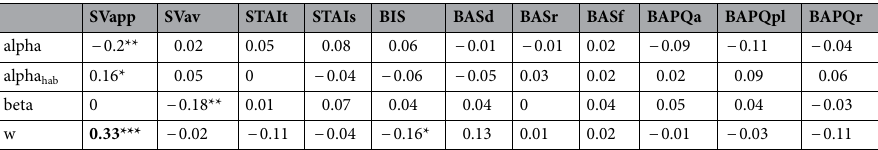
Table 3. Spearman’s correlations between counterfactual model parameters and subjective measures. Correlations in bold survive FDR correction for multiple comparisons.SVapp = subjective value for approach scenarios, SVav = subjective value for avoidance scenarios, BIS = Behavioral Inhibition System, BASd = Behavioral Activation System, Drive subscale, BASr = Behavioral Activation System, Sensitivity to Reward subscale, BASd = Behavioral Activation System, Funseeking subscale, BAPQa = Broad Autism Phenotype Questionnaire, Aloof Personality, BAPQpl = Broad Autism Phenotype Questionnaire, Pragmatic Language, BAPQr = Broad Autism Phenotype Questionnaire, Rigidity. *= p < .05, **= p < .01, ***= p <